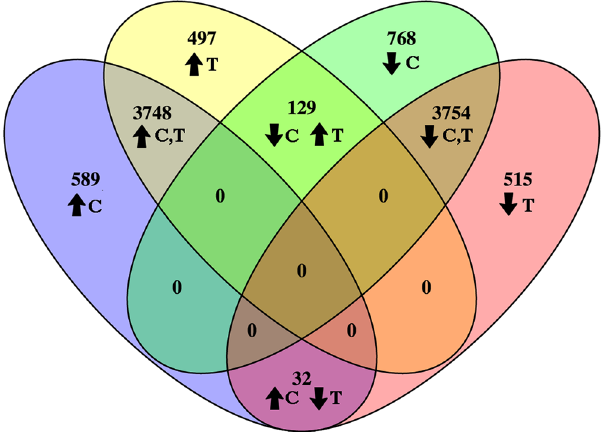
Figure 1. Venn Diagram of CXCL12- and TGF β -Induced Transcriptomes. EdgeR analysis of gene